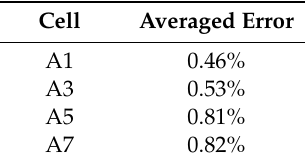
Table 6. Average error during charge estimation of Li-ion batteries’ charge at different cycles using cycle number higher than 250.